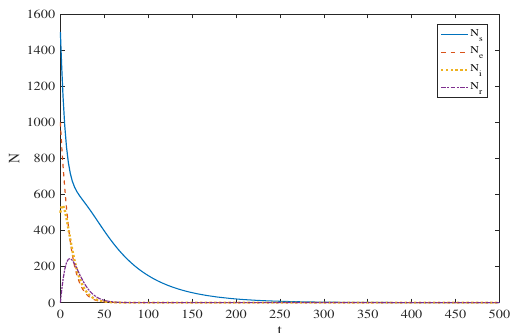
Figure 1. Local asymptotic stability of the disease-free equilibrium point H 0 = ( 0,0,0,0 )